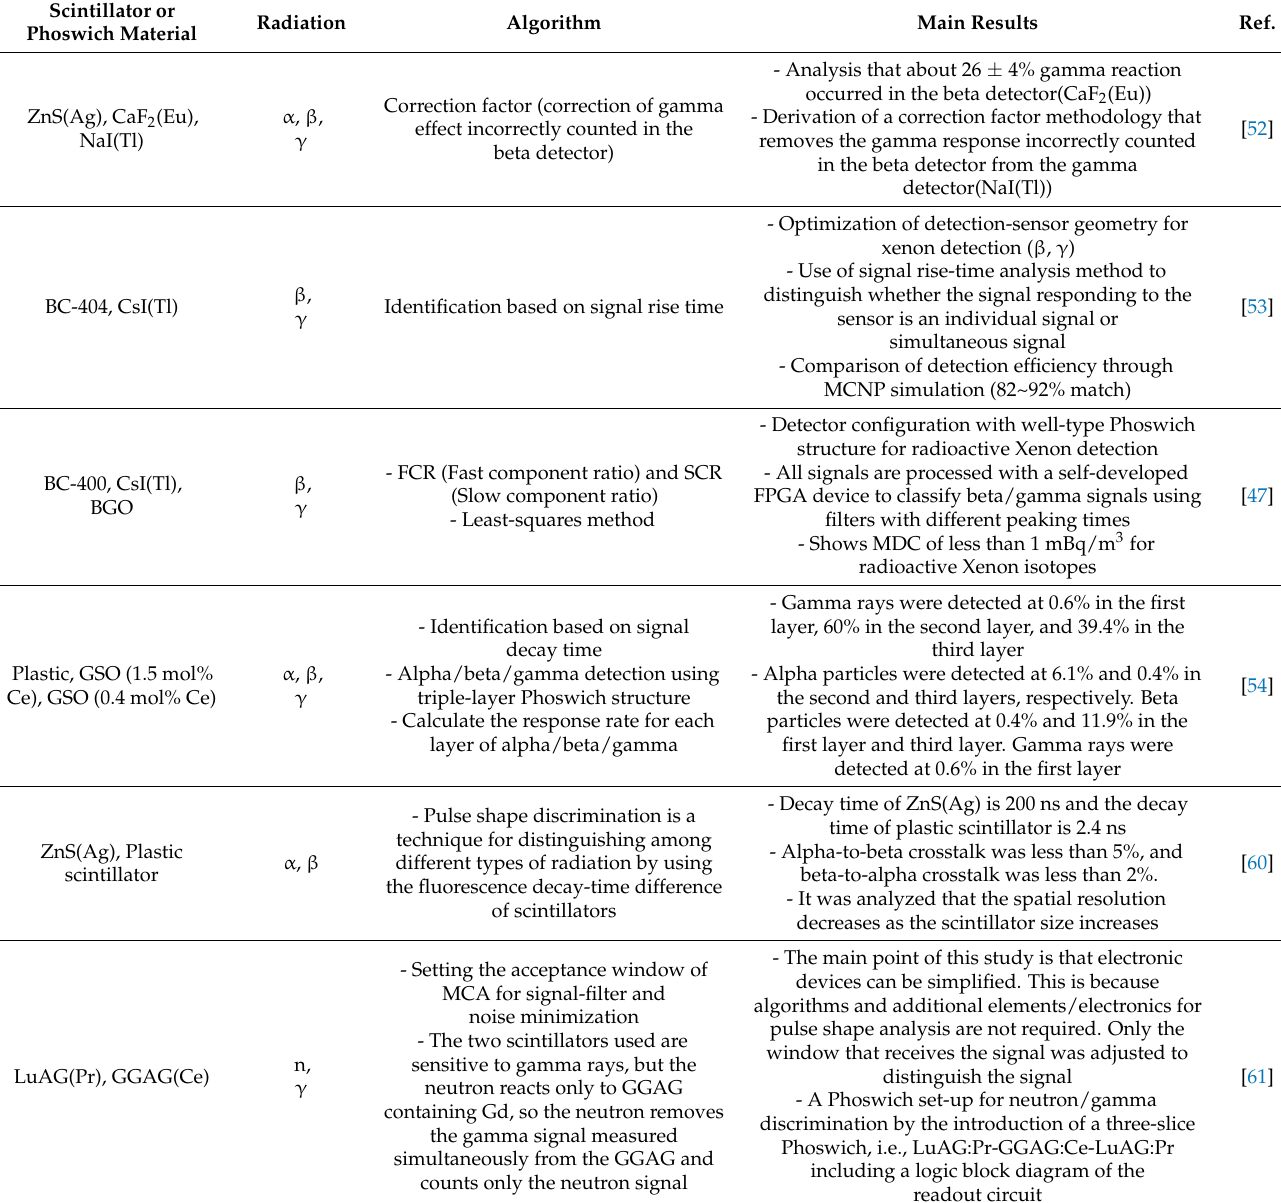
Table 6. Summary of Phoswich detectors in radiological